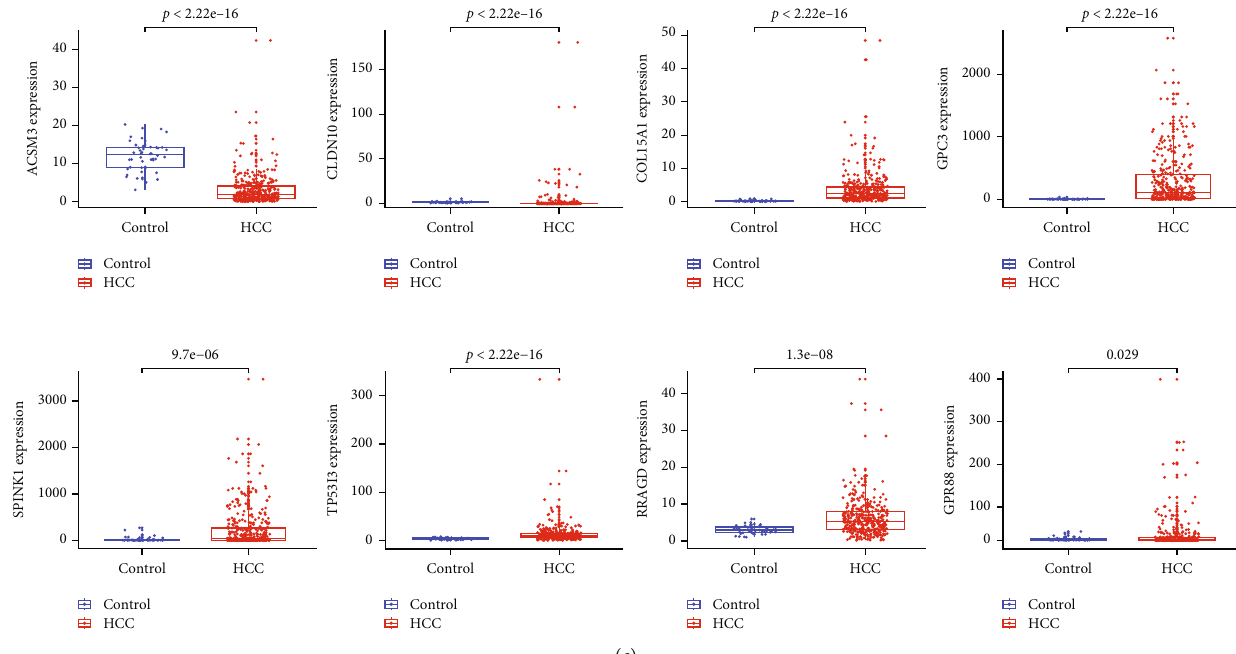
Figure 4: Veri fi cation of the expression levels of selected diagnostic gene markers in three validation cohorts. (a) GSE14520-GPL3921 cohort. (b) ICGC-LIRI-JP cohort. (c) TCGA